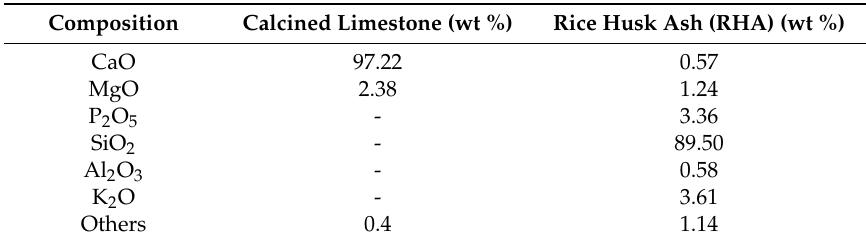
Table 1. Composition of the raw